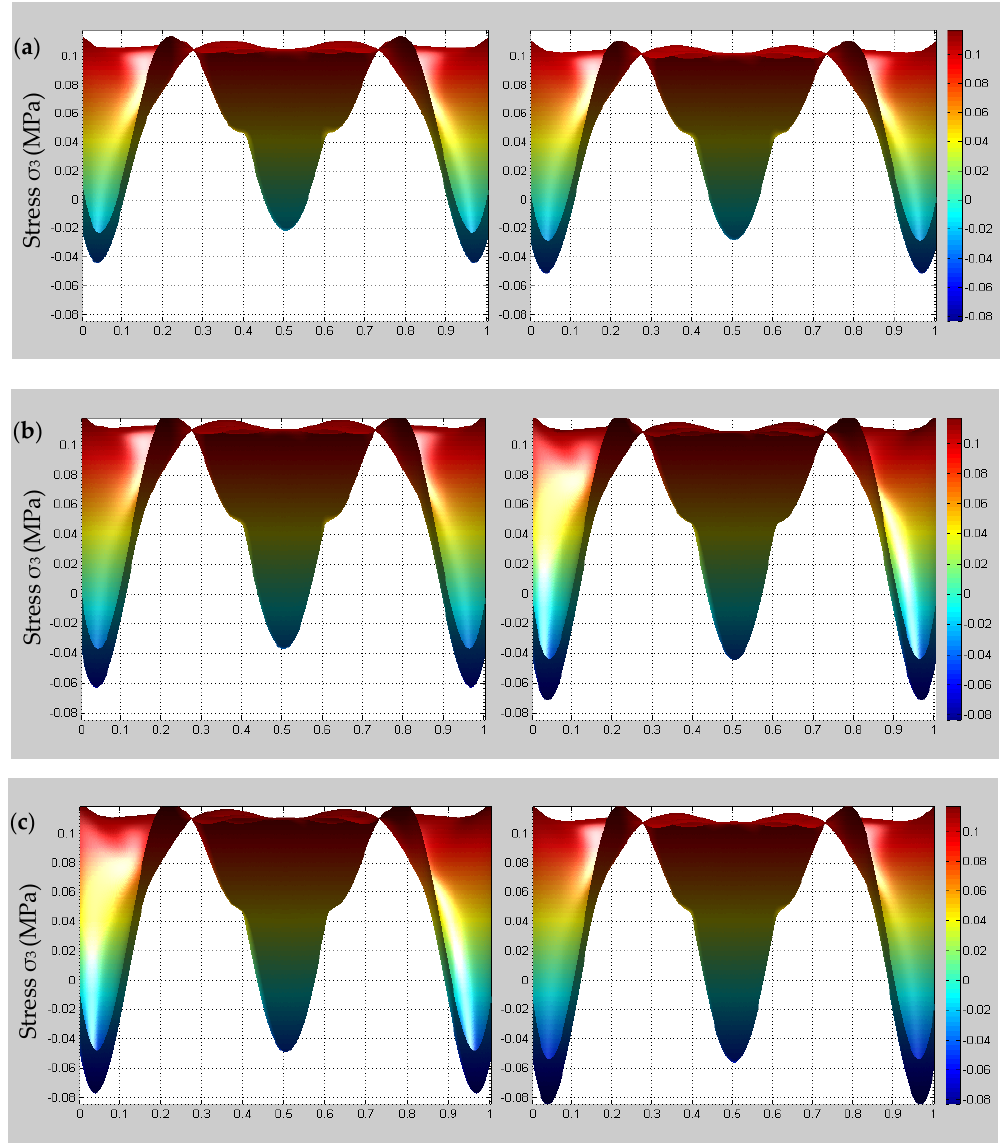
Figure 12. Comparison of the micro-scale stress σ 3 for a yarn before and after stabilization at different temperatures. ( a ) Ground state; ( b ) 35 °C; ( c ) 45 °C.